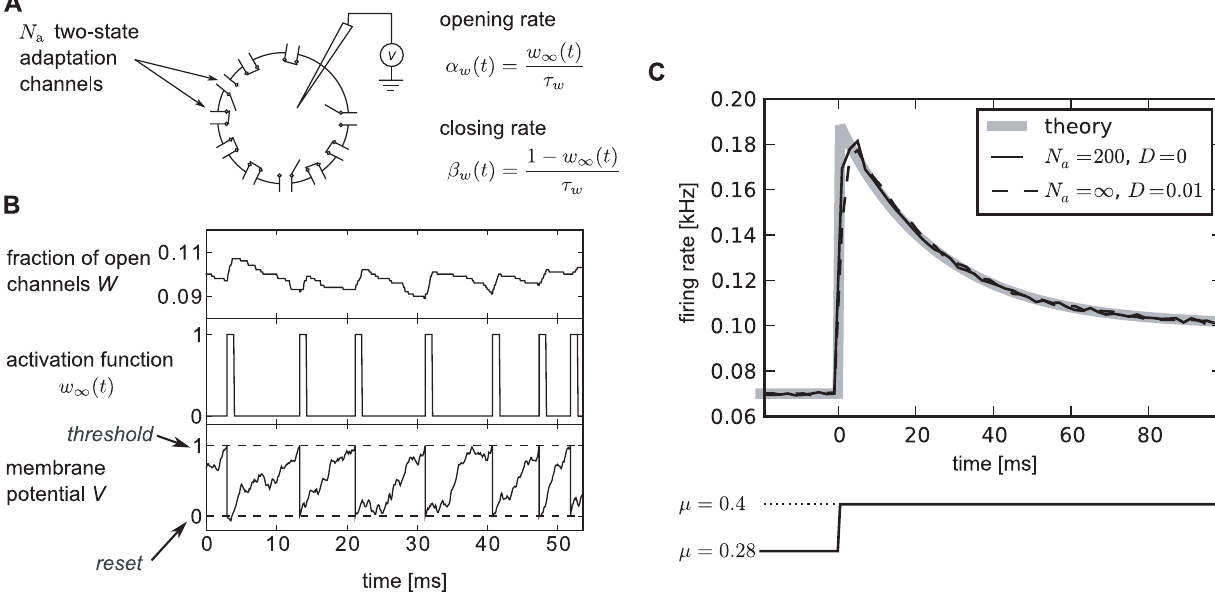
Figure 1. Integrate-and-fire dynamics with adaptation channels. A Channel model: a population of N a independent voltage-gated ion channels, which can be either in an open or a closed state, mediate an adaptation current through a neuron’s membrane. B PIF model: Subthreshold dynamics of the membrane potential V (bottom). The variable V (measured in units of V th ) is reset to a value V reset ~ 0 after crossing the threshold at V ~ V th . Action potentials are not generated explicitely. Instead, the effect of an action potential is captured by the activation function w ? ( t ) , which is set to one in a short time window of 1ms following each threshold crossing of the IF model (middle panel). The adaptation current is proportional to the fraction of open channels W (top panel). The sample traces were obtained from a simulation of Eq. (35) with N a ~ 1000 channels, white noise (cid:3) ms , adaptation time constant t ~ 100ms , base current m ~ 0 : 4 V ~ 3 V intensity D ~ 0 : 01 V 2 w th = ms and maximal adaptation current b th = ms . C The th time-dependent firing rate (top) in response to a step stimulus (bottom) is independent of the source of noise (stochastic adaptation – solid line, deterministic adaptation plus white noise – dashed line). The gray line shows the theory given by Eq. (55).